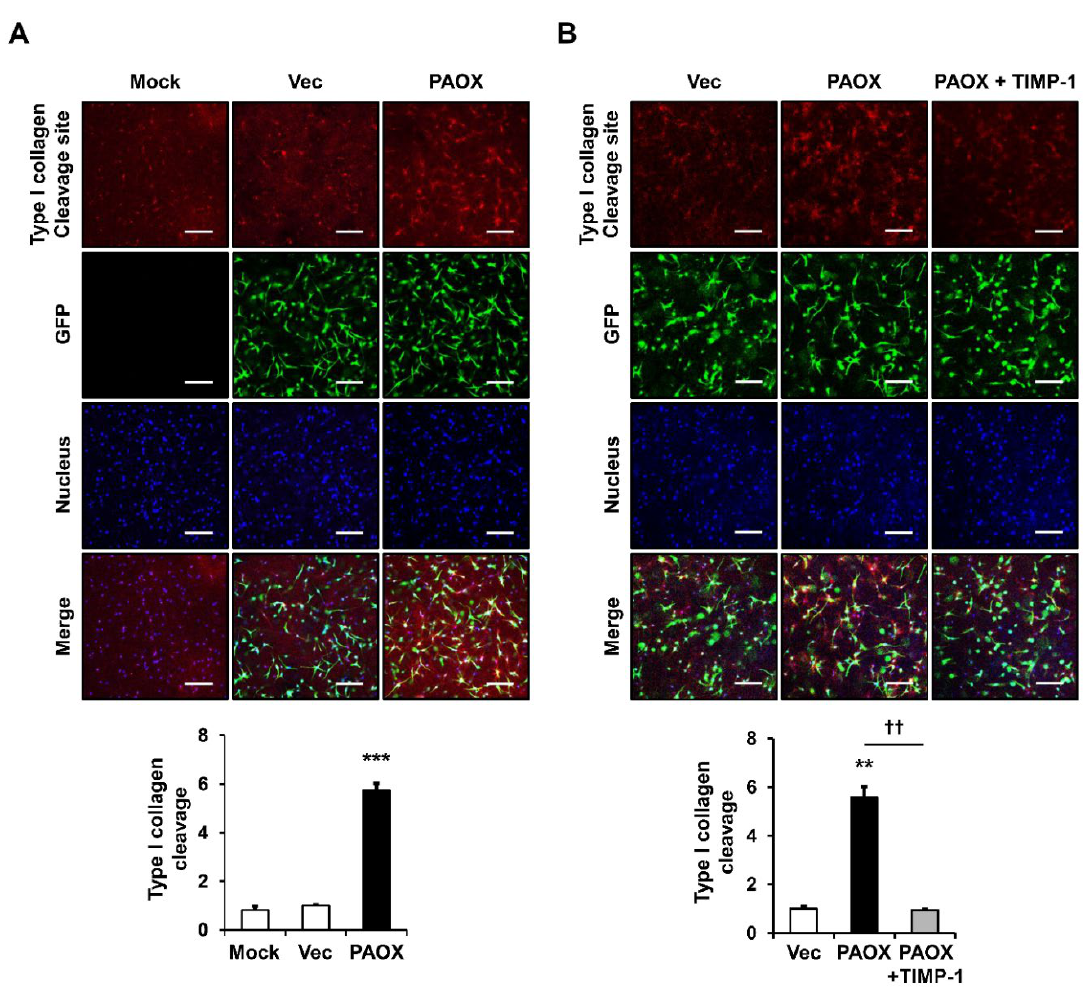
Figure 2. Effect of PAOX expression on type I collagen degradation in a 3D culture of fibroblasts. Fibroblasts mock-infected or infected with vector viruses or PAOX viruses were embedded in a type I collagen matrix and incubated in a serum-free and phenol-red-free DMEM for 24 h ( A ) without or ( B ) with 1 µ g/mL tissue inhibitor of metalloproteinases-1 (TIMP-1). Fibroblasts were subjected to immunofluorescence (IF) staining for type I collagen degradation using a rabbit anti-type I collagen cleavage-site antibody and a Rhodamine Red X-conjugated anti-rabbit IgG antibody. Nuclei were stained with Hoechst 33258 and were used for normalization of fluorescence values. The fluorescence levels of type I collagen degradation were measured using ImageJ software and are presented as a graph. Each value represents the mean ± standard deviation of three independent experiments. ** p < 0.01 and *** p < 0.001 vs. vector control. †† p < 0.01 vs. PAOX. Magnification, × 100. Bar = 200 µ